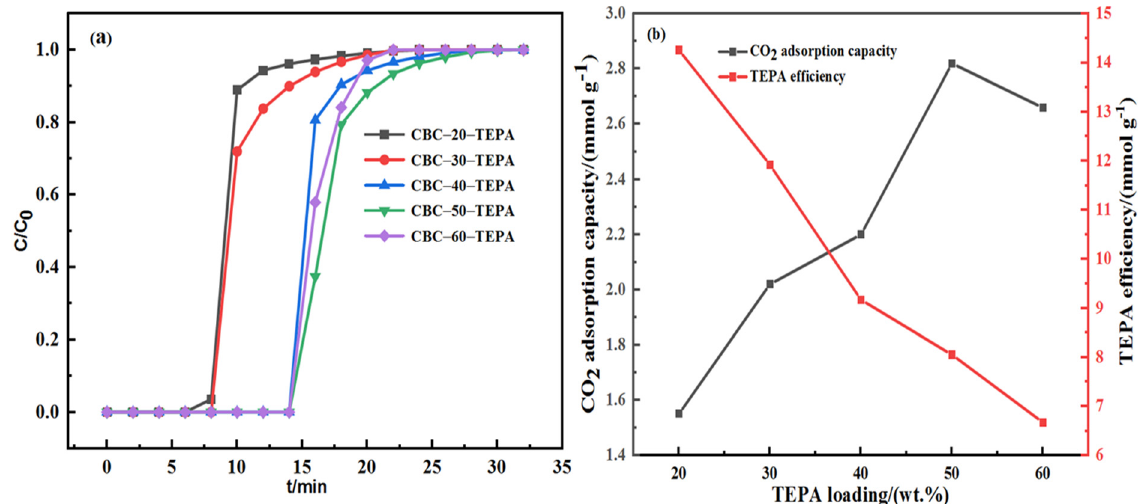
Figure 7. Breakthrough adsorption curves of CO 2 ( a ), and CO 2 adsorption capacity and TEPA efficiencies of CBC-X-TEPA ( b ).